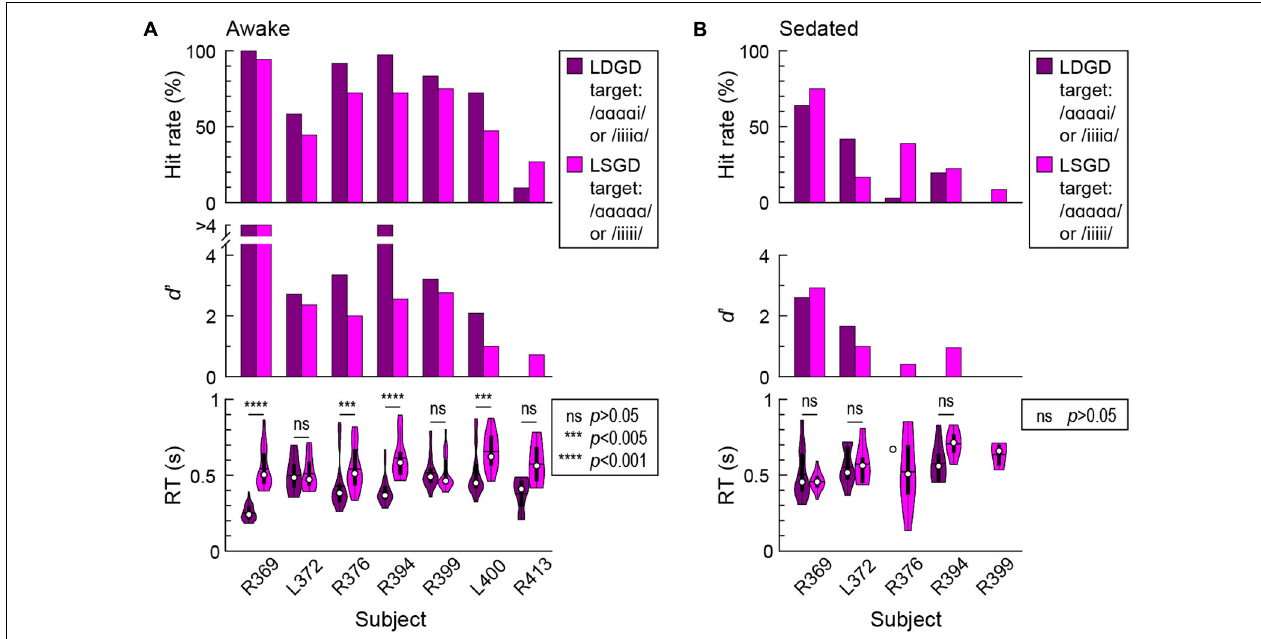
FIGURE 4 | Global deviance (GD) target detection task performance in the awake (A) and sedated (B) states. Summary of data from seven subjects. Hit rates (% correctly detected target stimuli), sensitivity ( d ’) and RTs are plotted in the top, middle, and bottom panels, respectively. In the sedated state, subject R399 did not have correct hit responses to LDGD targets, and subjects L400 and R413 did not have correct hit responses to either LSGD or LDGD targets.